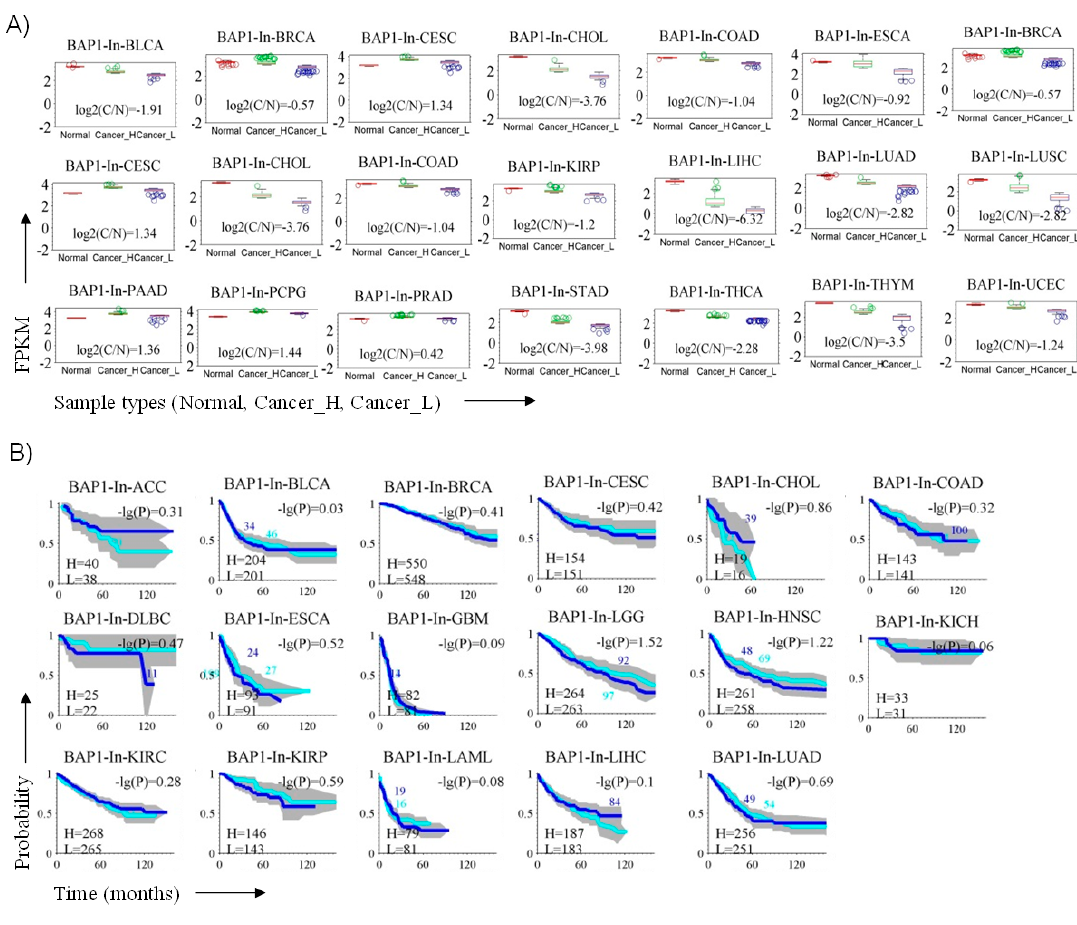
Figure 4. Figure cont.